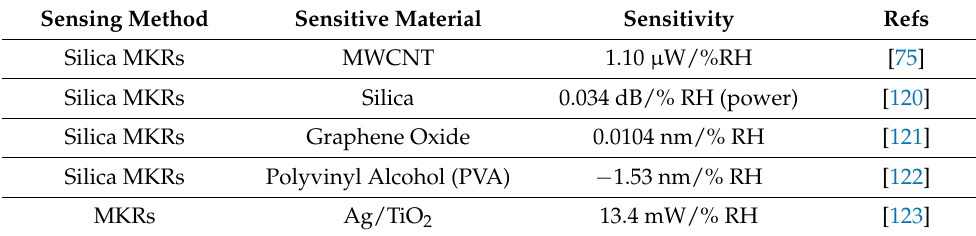
Figure 19. The schematic sensor structure of ( a ) microfiber resonators (MRs) and ( b ) microfiber knot resonators (MKRs). The arrows indicate the light paths. Table 7. A brief comparison of MKRs humidity